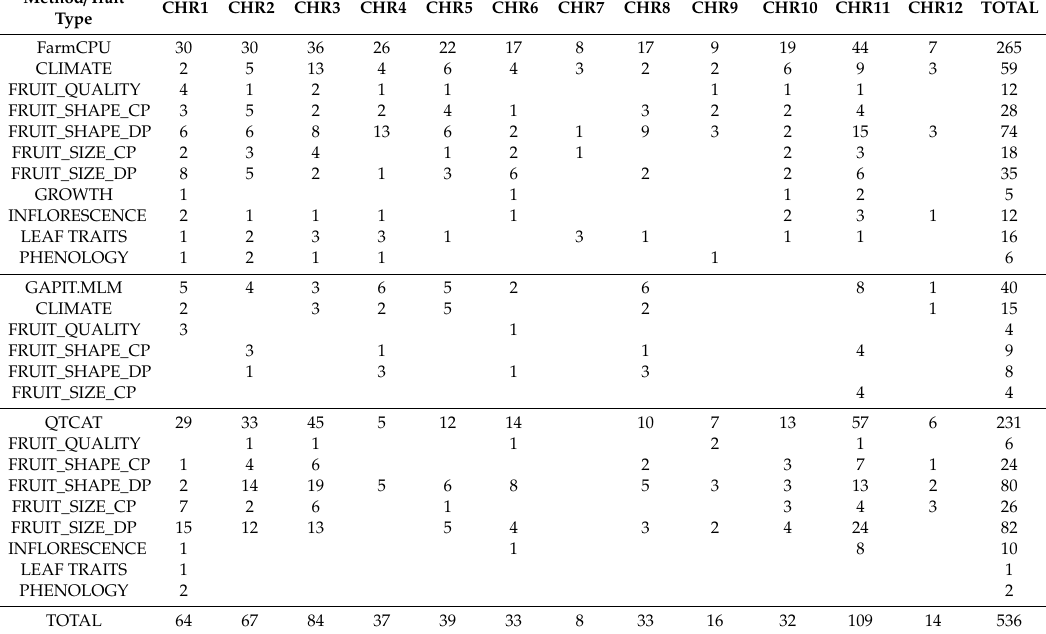
Table 5. Distribution and number of marker-trait associations detected along tomato chromosomes. Data are presented according to the GWAS method and then trait type. FRUIT_SHAPE_CP and FRUIT_SIZE_CP / DP, fruit shape and size, respectively, based on conventional / digital phenotyping. Method / Trait Type